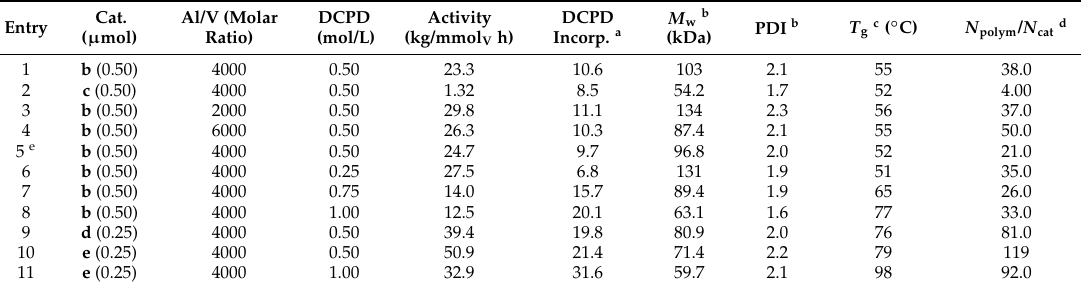
Figure 6. ( a ) 1 H spectrum and ( b ) 13 C spectrum of E/DCPD copolymer with DCPD of 15.7 mol % (entry 7 in Table 3) prepared by e /Et 2 AlCl/ETA catalytic system.